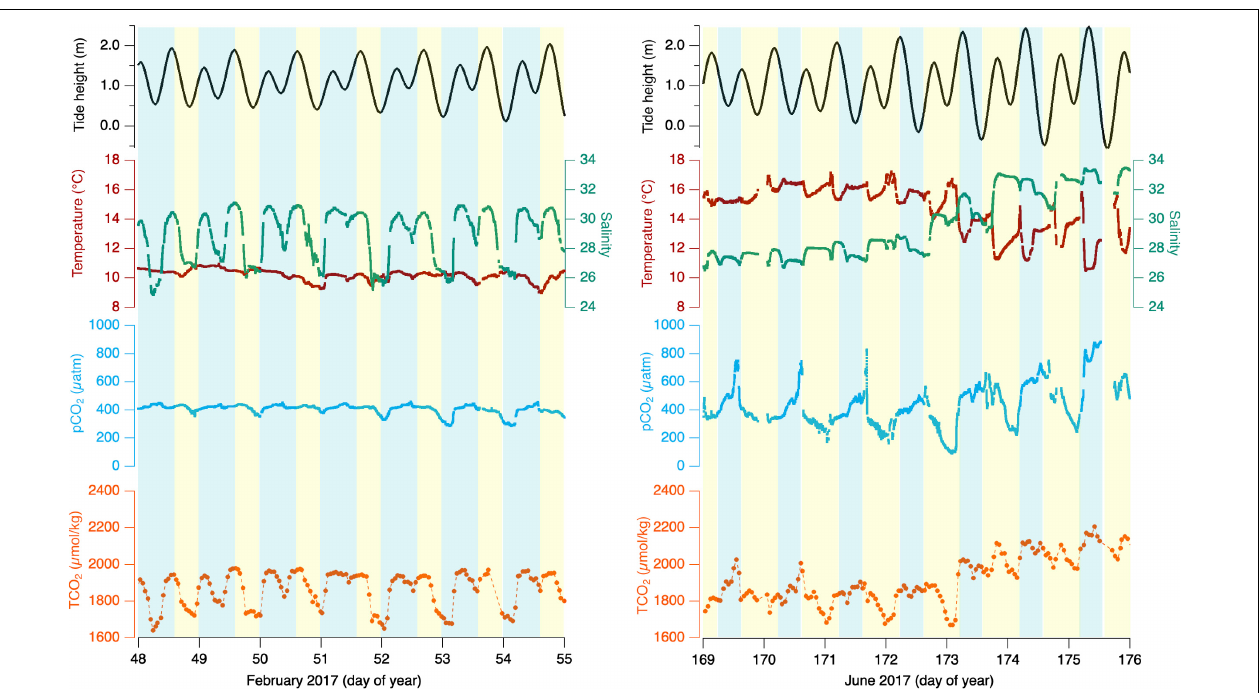
FIGURE 2 | 7-day period winter (Left) and summer (Right) 2017 for Netarts Bay, OR, time in day of year UTC. Temperature (red line), salinity (teal line), pCO 2 (cyan line), TCO 2 (orange dots connected by dashed line), and estimated tide height (black line). Blue shading indicates local nighttime and yellow shading indicates local